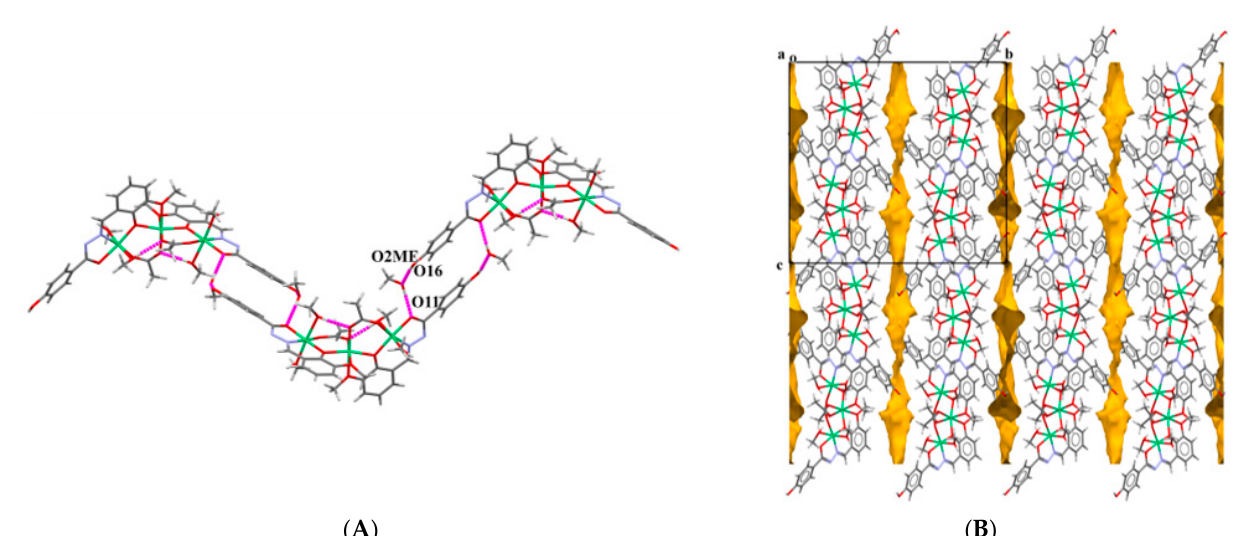
Figure 1. ORTEP view of molecular structure of 1 ∙ 2MeOH ∙ MeCN. The displacement ellipsoids are drawn at the 50% probability level at 150(2) K. The solvent molecules of crystallisation have been omitted for clarity.